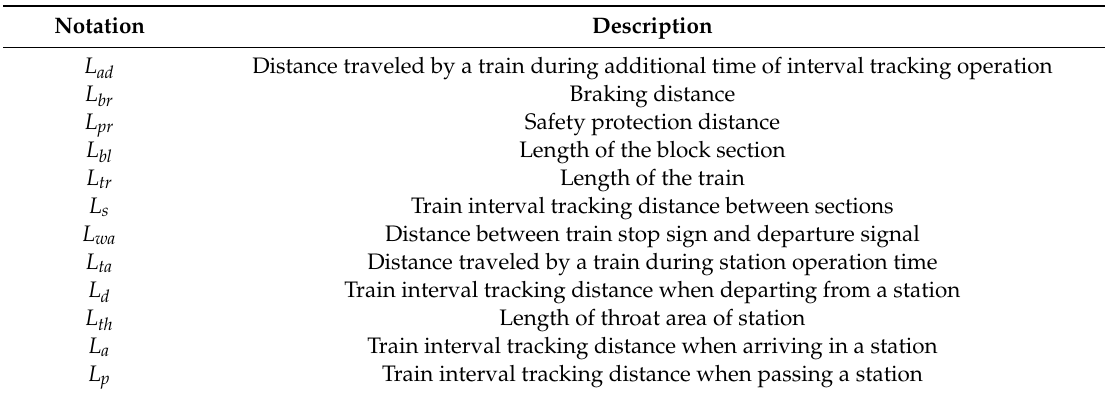
Figure 1. Diagram of the train headways in China. Table 2. Definitions of the parameters in Figure 1.